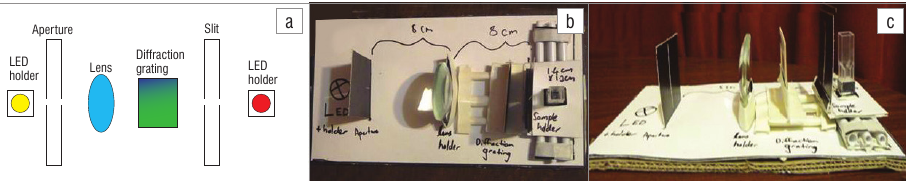
Figure 1: The first spectrophotometer prototype: (a) schematic layout of the optical plate and (b) an overhead view and (c) side view of the optical